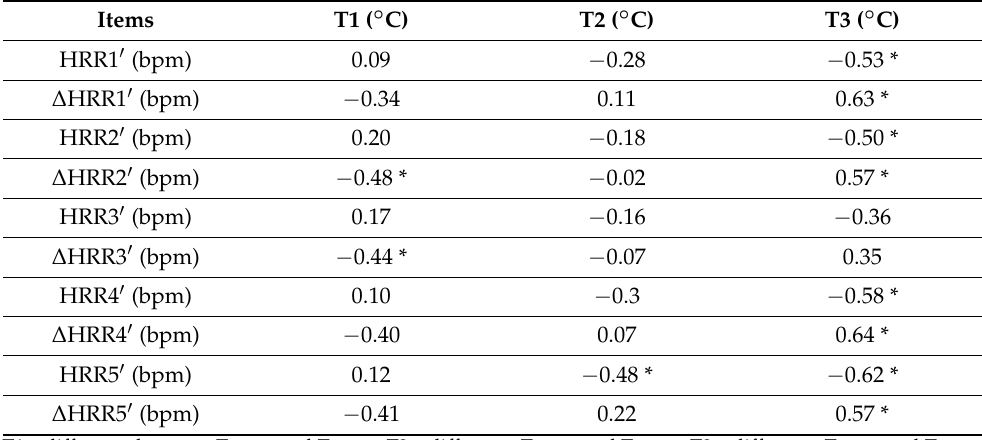
Table 5. Pearson correlation between thermal parameters and recovery heart rate.